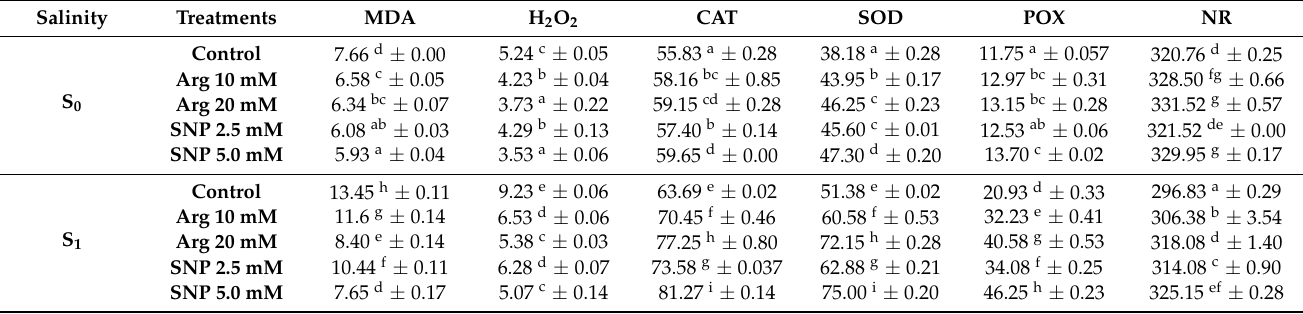
Table 3. Effect of arginine on MDA, H 2 O 2 ( µ g g − 1 fresh weight) and antioxidant enzymes (CAT, SOD, POX ( µ g g − 1 fresh weight/h) and NR (n mole NO 2 /g fresh weight/h) of wheat plant grown